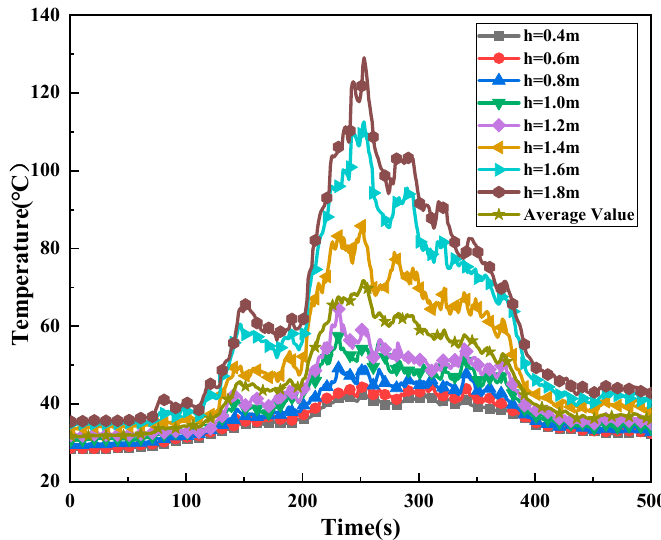
Figure 6. Temperature changes at different heights of the 1# thermocouple tree in the cabin ( V s = 2.058 m 3 /s ).